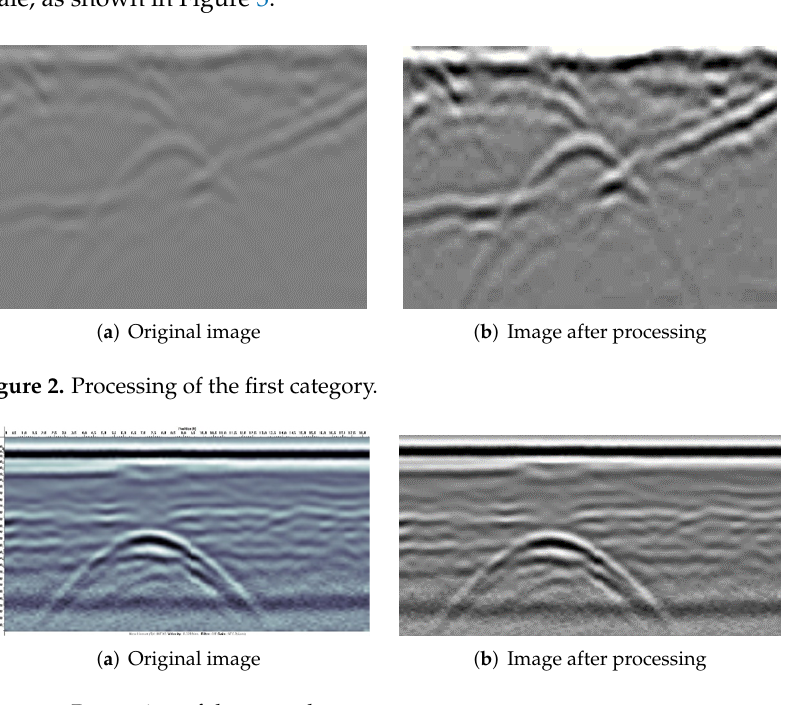
Figure 3. Processing of the second